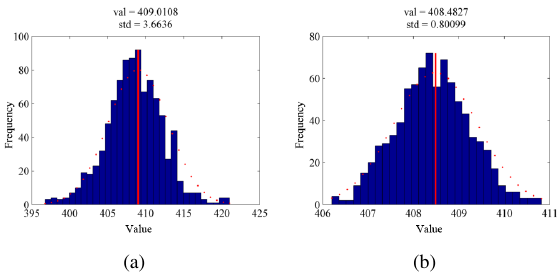
Figure 4. Fitting a gaussian function to 1 000 adjustment results of the focal length (thermal imaging sensor). Maximum of the gaussian function is used as value. (a) Value derived from 10 random triplets. (b) Value with lower standard deviation derived from 30 random triplets.